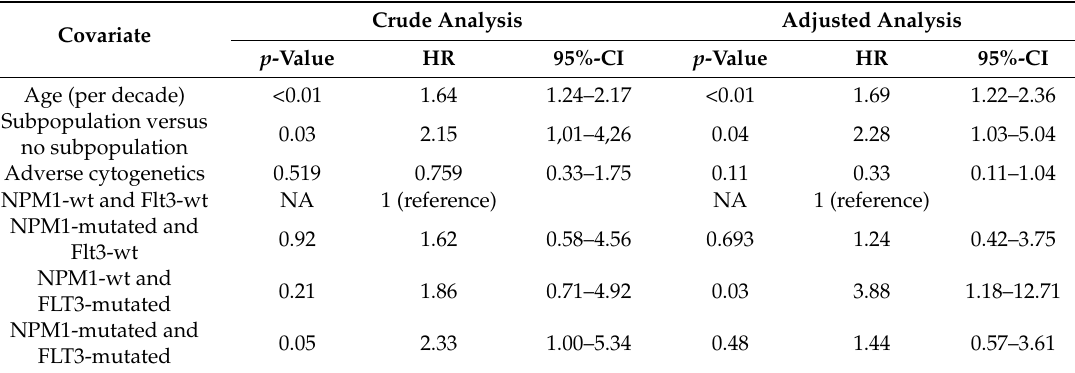
Table 1. A comparison of overall survival for patients with and without dual populations based on the analysis of PI3K-Akt-mTOR activation. The table presents the results from univariate and adjusted or multivariate analyses (Cox Proportional Hazard Model). Significant p -values in the adjusted analysis are marked in